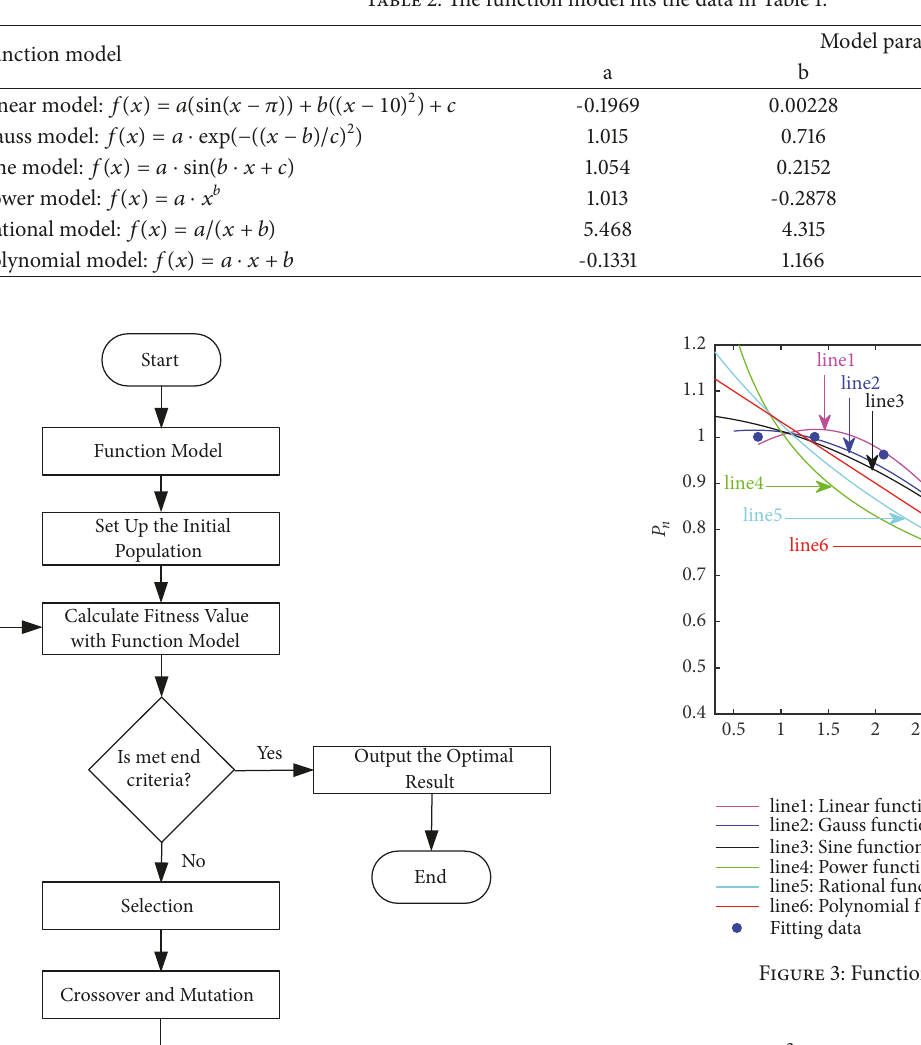
Figure 2: The flowchart of function model algorithm using MGA.